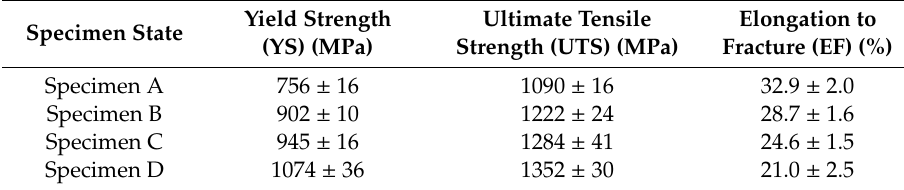
Table 1. Mechanical properties of Inconel 718.